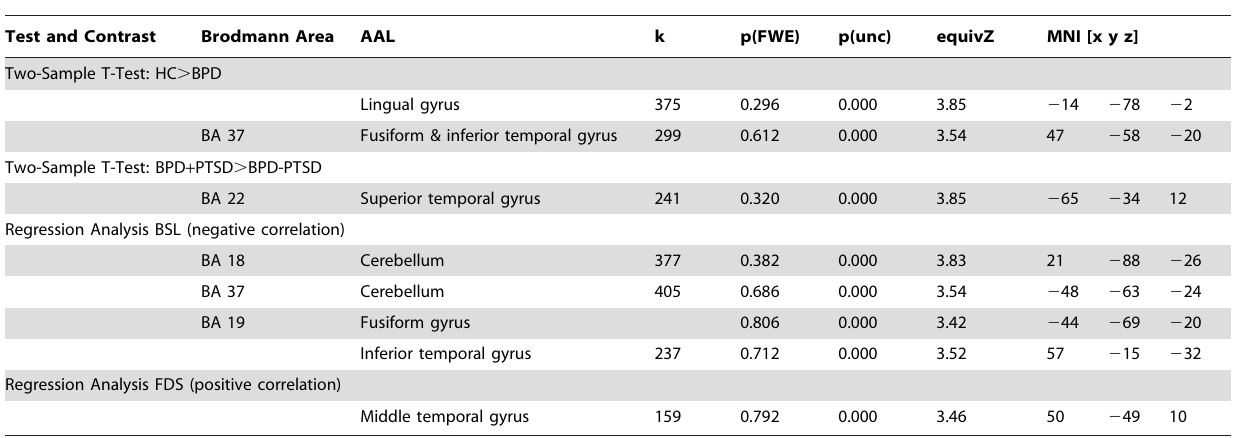
Table 2. Whole Brain Results of voxel-based analyses of gray matter volume.